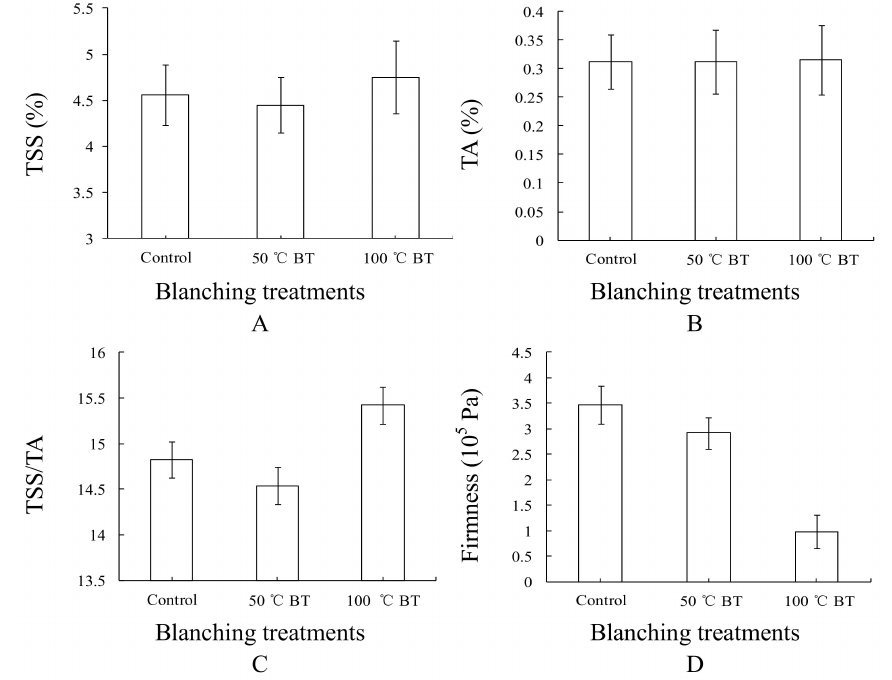
Figure 2. Physicochemical parameter changes of BT and control tomato during storage. ( A ) TSS change, ( B ) TA change, ( C ) TSS/TA change, ( D ) Firmness change. Each treatment was represented by an average value with standard deviation of 8